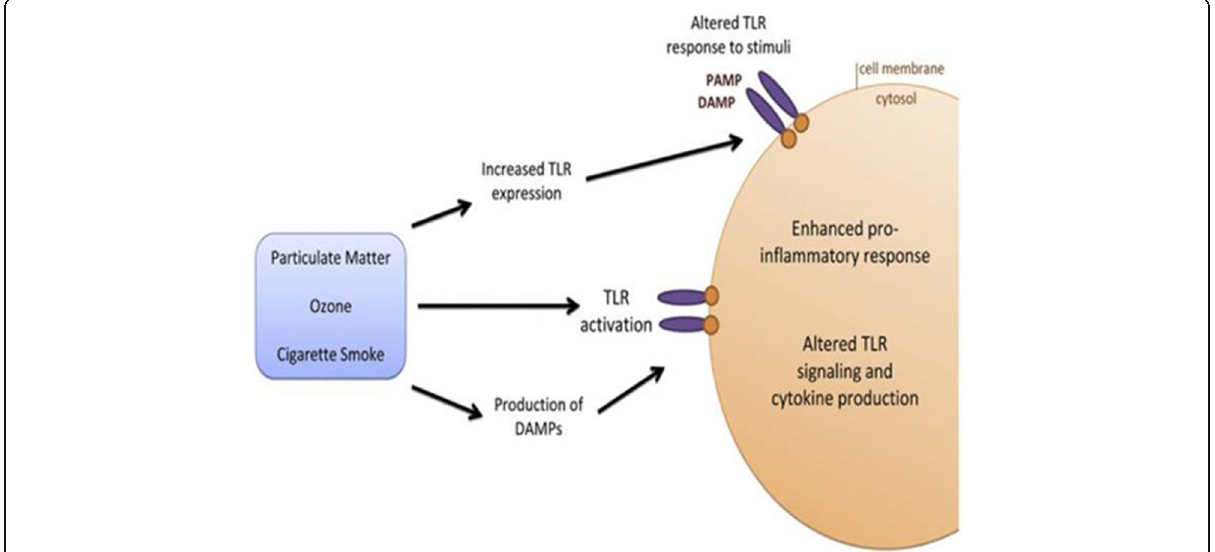
Fig. 3 Effect of air pollutants on TLRs